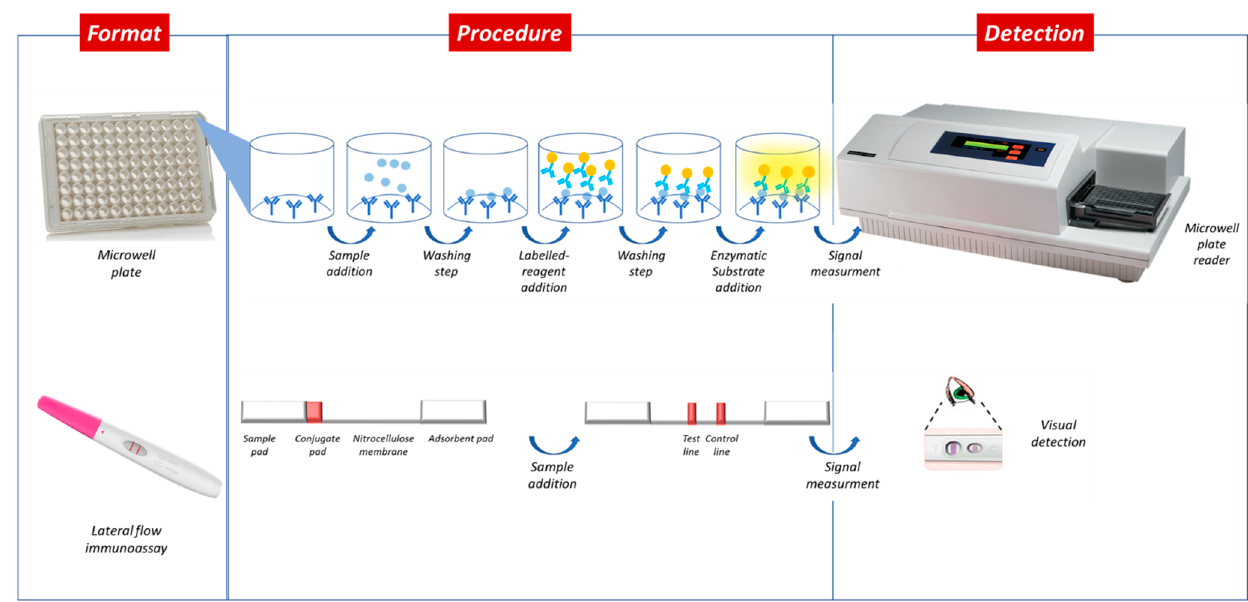
Figure 1. Scheme of the major differences among the conventional immunoassay format approaches based on bench-top instrumentation used in an equipped laboratory setting (top line) and a rapid and portable platform exploiting the LFIA principle for on-site applications (bottom line).